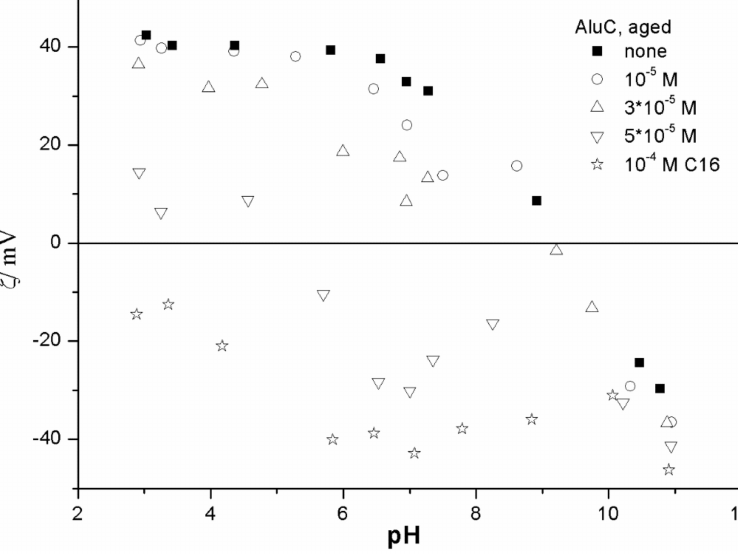
Figure 8. The ζ potential of alumina in aged dispersions in the presence of sodium